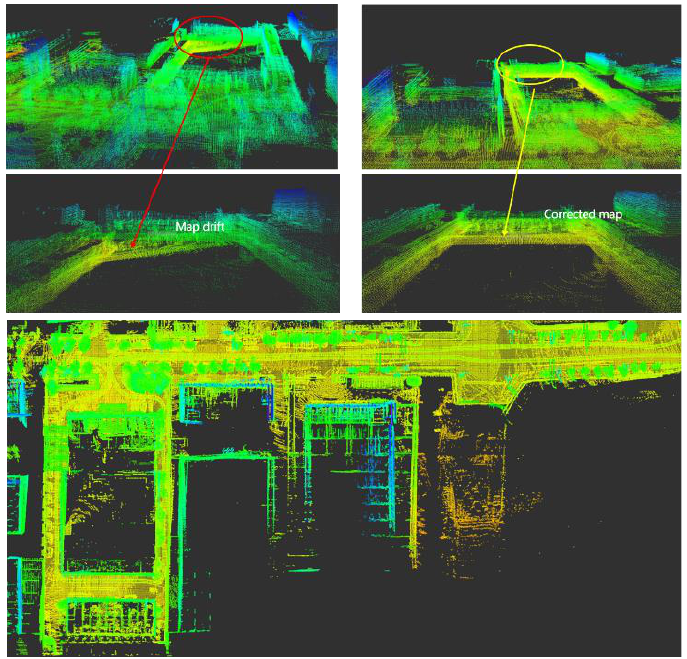
Figure 13. The map drift in large scale scenario is eliminated by back-end optimization. The figure on the upper left is unoptimized, and the upper right one is optimized. It can be seen that the map drift of the optimized map is significantly reduced. The bottom figure is the complete large-scale map after optimization.